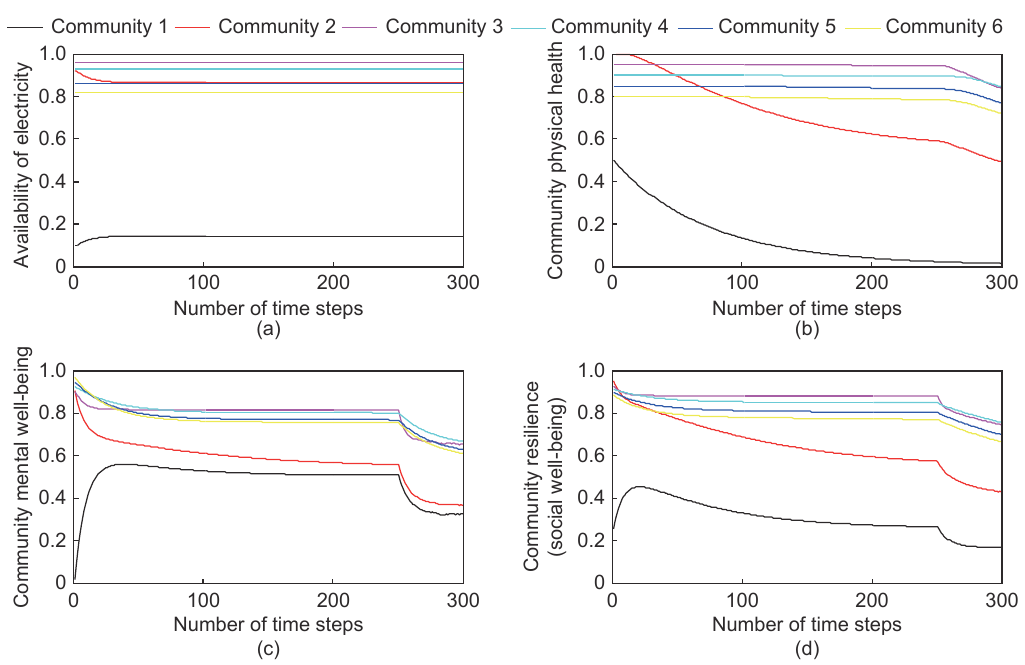
Fig. 10 Trends of the availability of electricity, physical health, mental well-being, and community resilience for six communities. Because the disaster only strikes Community 1, its people have the lowest level of physical health, mental well-being, and community resilience. Because Community 2 has a close relationship with Community 1, the mental well-being of its people is affected by this disaster; consequently, its resilience is